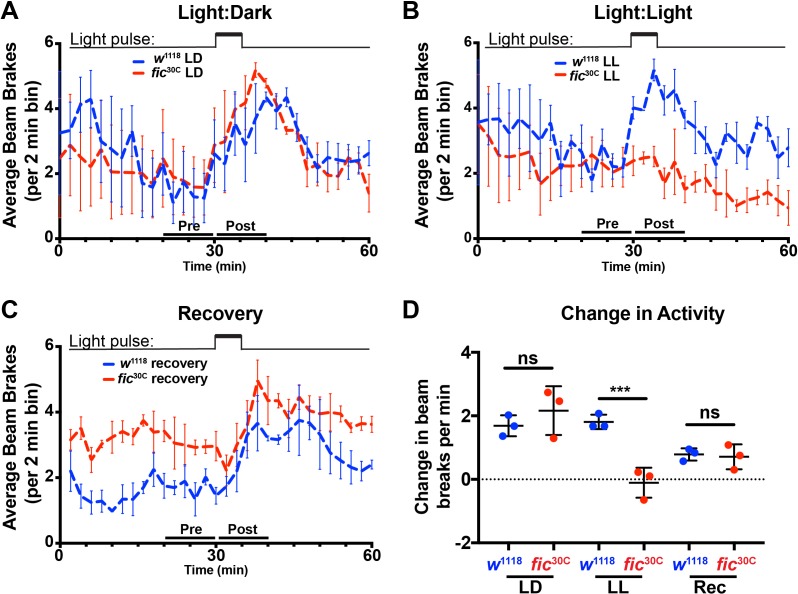
Light-induced defects in light-startle activity in fic30C mutants.(A, B, and C) Actogram of w1118 or fic30C flies reared in LD for three days (A), LL for three days (B), or recovery condition (three days in LL then three days in LD) (C). Light pulse is indicated by upper bars. Data is averaged from three biological replicas, each containing 16 flies per genotype. Data were collected in two-minute bins. Error bars represent Standard Error. (D) Quantification of change in beam breaks per 2 min bin for the 10 min intervals before and after the onset of the light pulse in each experiment. Bar graphs show means ± SD. ***p<0.01, n = 3 experimental repeats with 16 flies per genotype and condition. Dead flies and those with a change in activity greater than three deviations from the median were excluded.10.7554/eLife.38752.016Figure 3—figure supplement 1—source data 1.Relates to Figure 3—figure supplement 1A, B, C and D.Quantification of light-induced startle behavior- average activity and delta calculations.